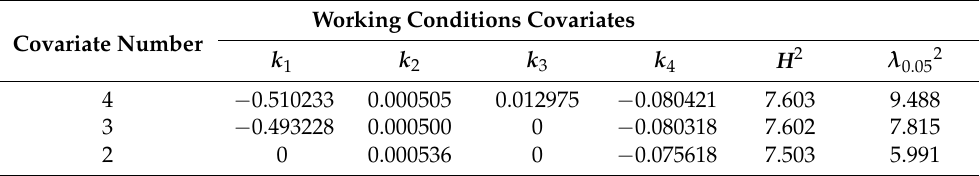
Table 2. The results of coefficients of all WC